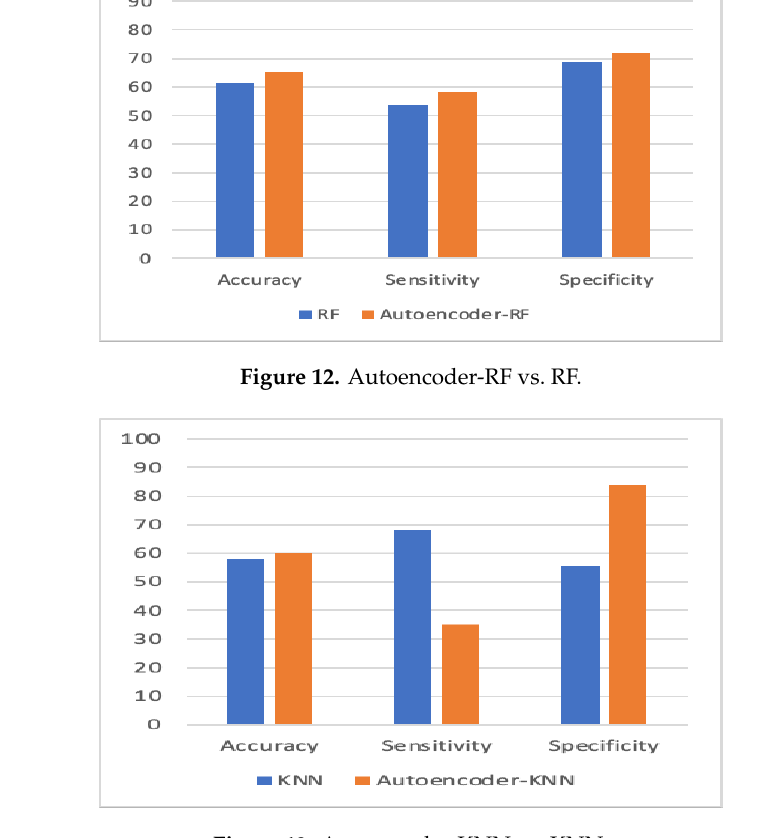
Figure 13. Autoencoder-KNN vs. KNN.